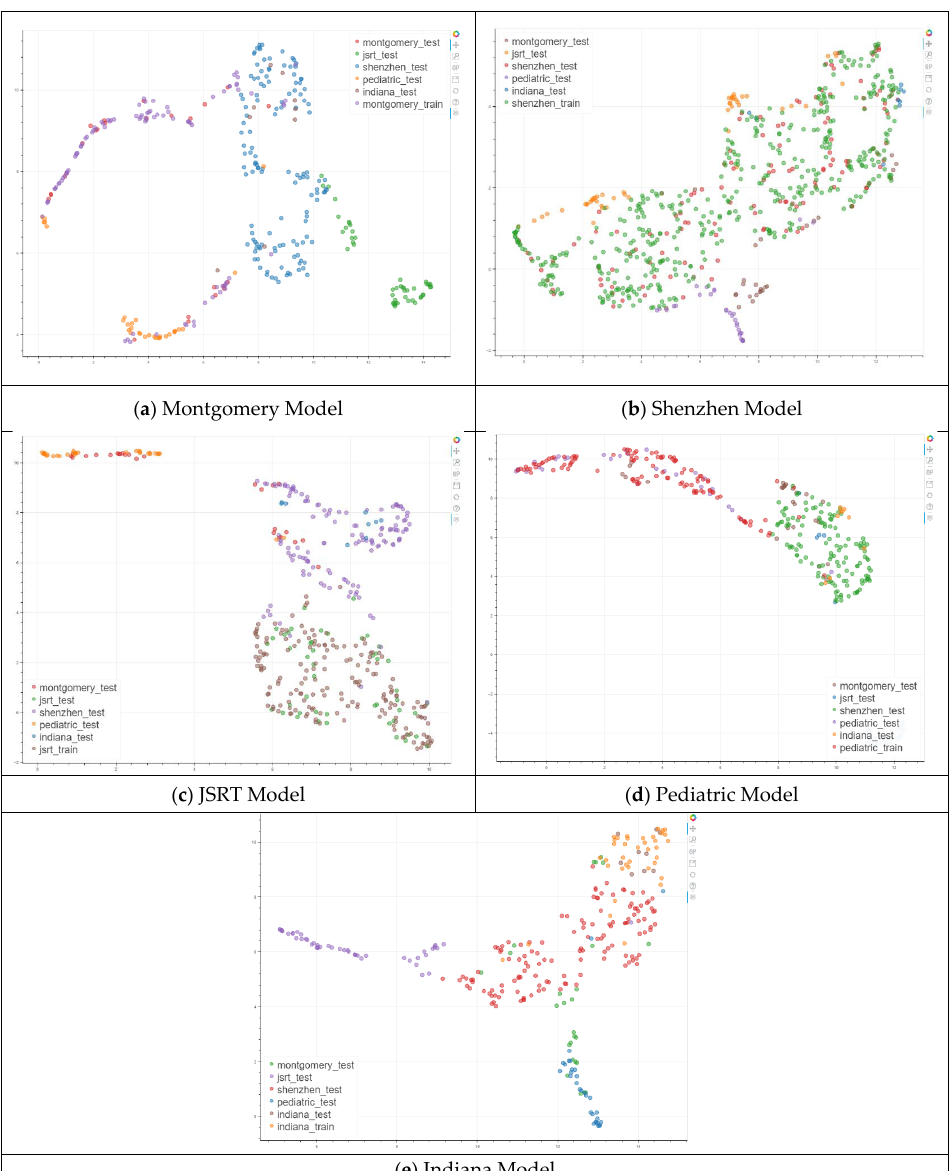
Figure A1. UMAP of YOLOv5 features extracted from individual dataset models.